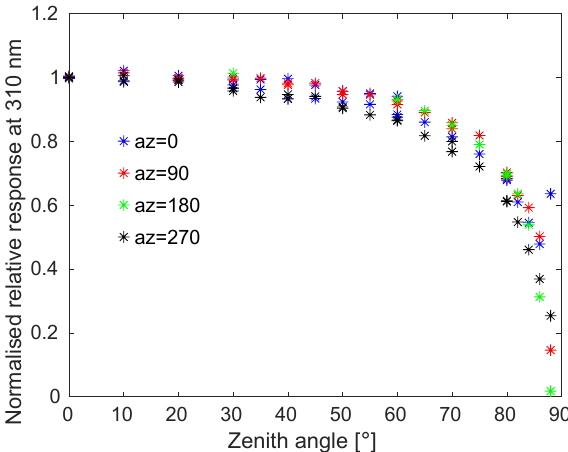
Figure 2. The cosine error of Brewer no. 214, FMI, Sodankylä, measured during the QASUME site audit in 2014. Results are nor- malised to the ideal cosine